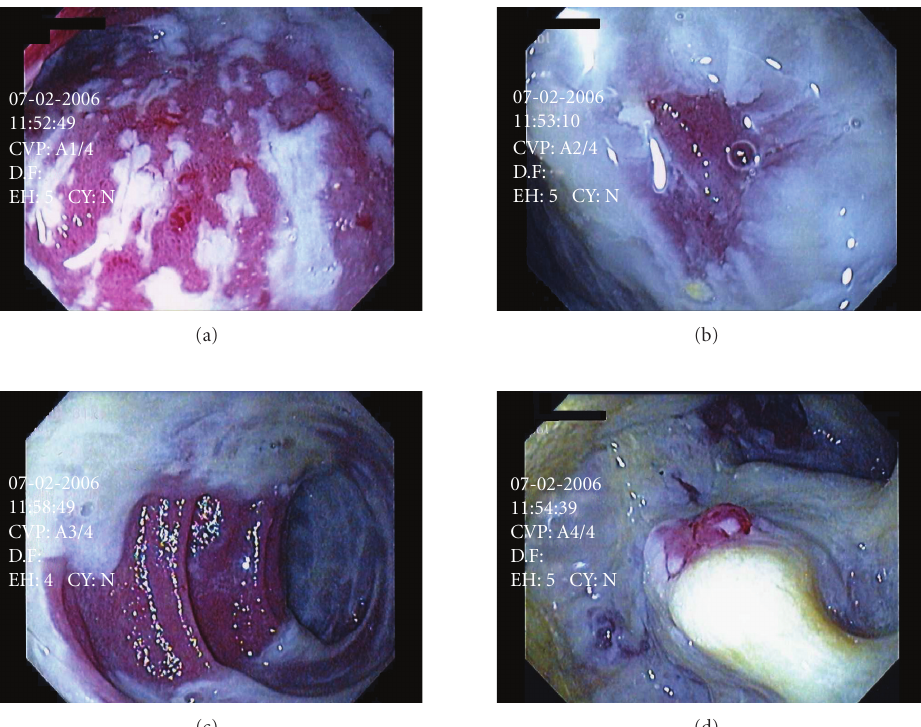
Figure 1: Flexible endoscopy of pelvic pouch demonstrating copious amounts of mucus with adherent pseudomembranes throughout the pouch and distal small bowel, consistent with C. di ffi cile